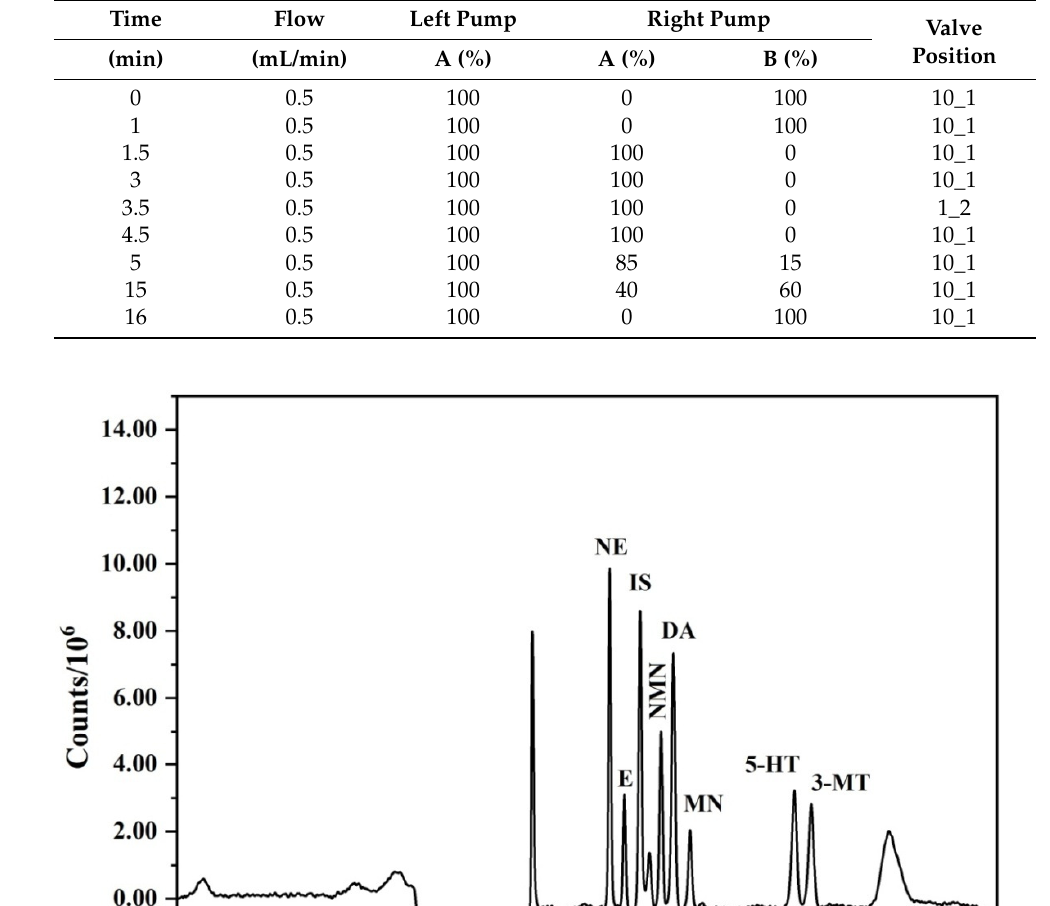
Table 1. The optimization procedures for on-line separation and enrichment of the biogenic monoamines and metabolites.